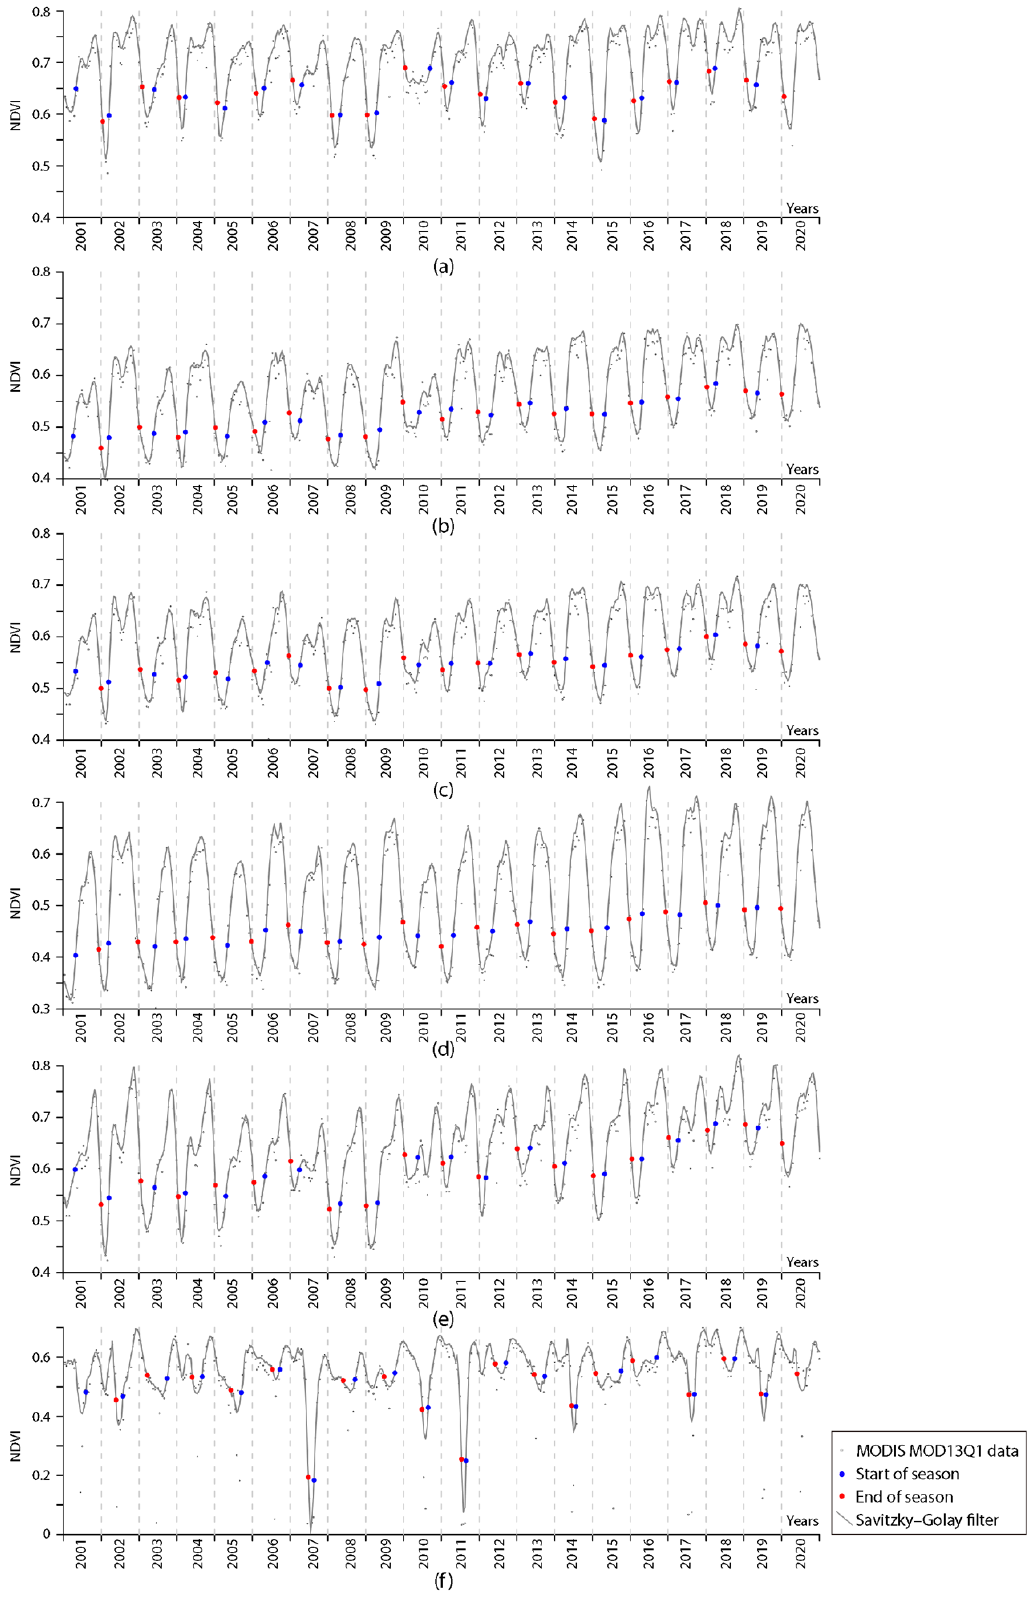
Figure A4. NDVI seasonal analysis with raw MODIS and fitted data marked as start of season and end of season from 2001 to 2020 in the six agro-climatics regions of Biobio: ( a ) Secano Costero, ( b ) Secano Interior, ( c ) Depresión Intermedia, ( d ) Cordón Isla, ( e ) Precordillera and ( f ) Cordillera.